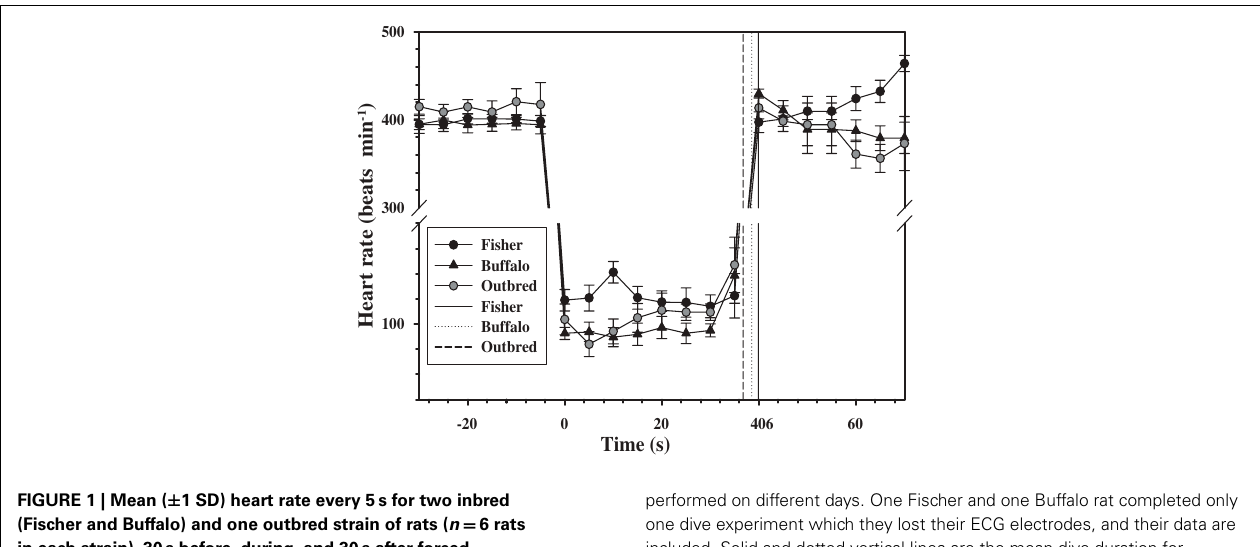
FIGURE 1 | Mean ( ± 1 SD) heart rate every 5s for two inbred (Fischer and Buffalo) and one outbred strain of rats ( n = 6 rats in each strain), 30s before, during, and 30s after forced submergence. The mean is for a total of three repeated forced dives